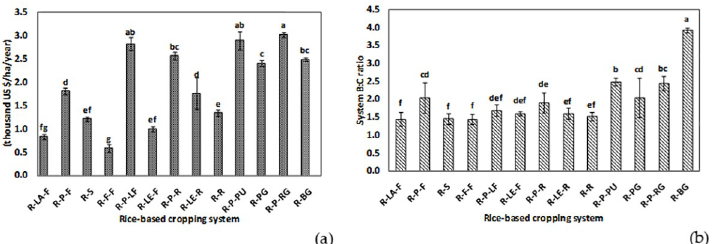
Fig 3. System cost of cultivation (thousand US$ha − 1 year − 1 ) (a) and B:C ratio (b) of different rice-based cropping systems of the study area [R-LA-F: rice-lathyrus-fallow, R-P-F: rice-potato-fallow, R-S: rice-sunflower, R-F-F: rice- fallow-fallow, R-P-LF: rice-potato-ladies finger, R-LE-F: rice-lentil-fallow, R-P-R: rice-potato-rice, R-LE-R: rice-lentil- rice, R-R: rice-rice, R-P-PU: rice-potato-pumpkin, R-PG: rice-pointed gourd, R-P-RG: rice-potato-ridge gourd, R-BG: rice-bitter gourd].